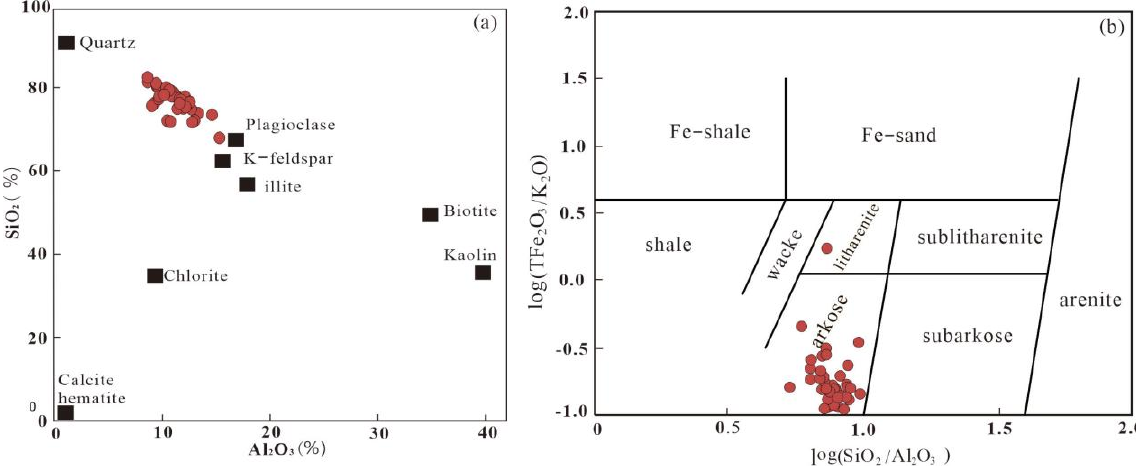
Figure 5. Diagram of the sandstones ( a ) and log(SiO 2 /Al 2 O 3 )−log(TFe 2 O 3 /K 2 O) diagram ( b ) (after Herro et al. [38]).